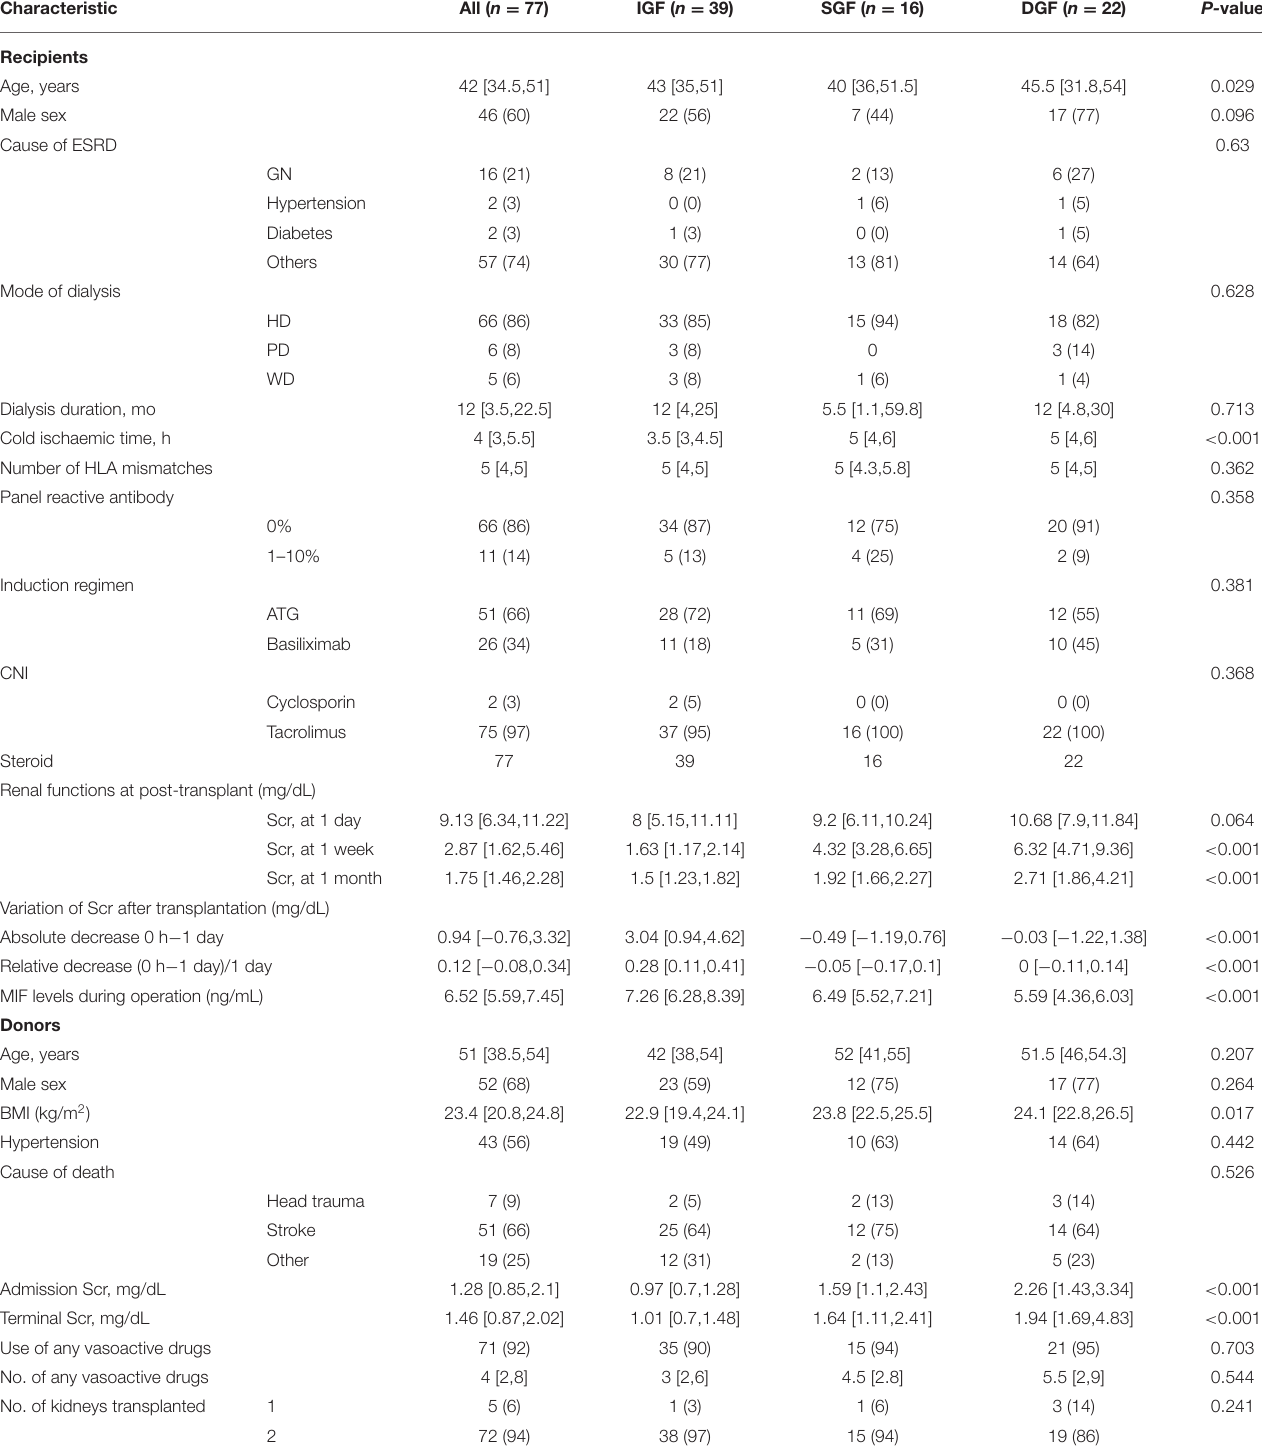
TABLE 1 | Summary of characteristics in recipient and donor, stratified by recipients’ s allograft function.